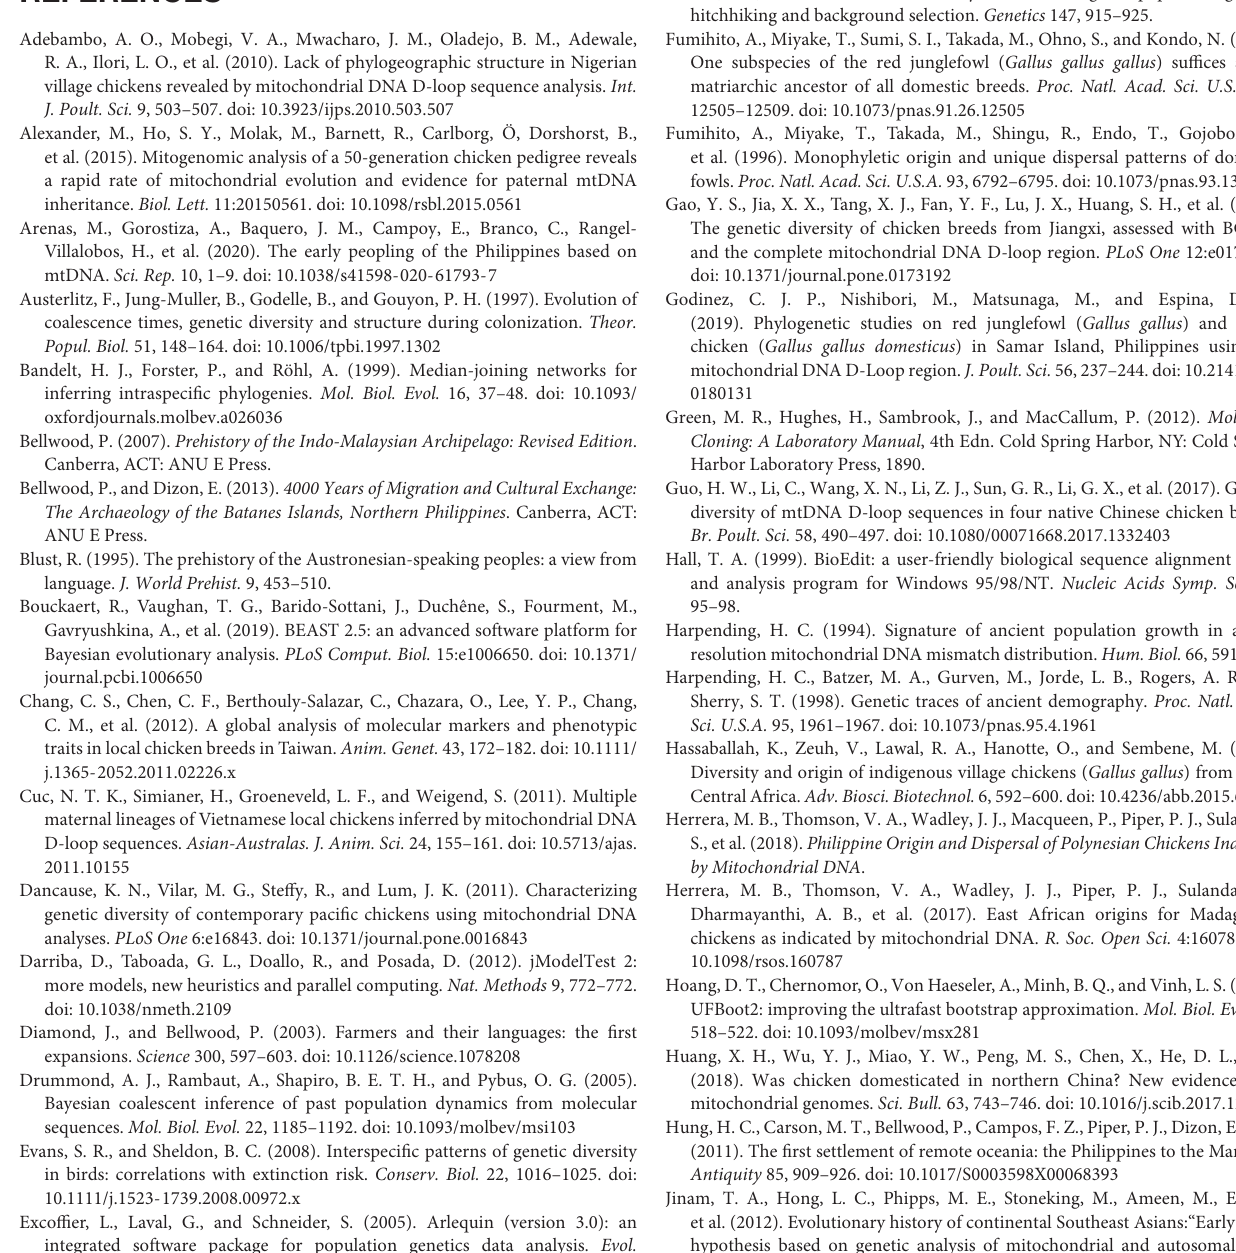
Genetic distance between Philippine–Pacific sub-clade and Philippine–Indonesian sub-clade are indicated by the length of branch corresponding for mutational positions. The area of each circle is proportional to the frequency of the corresponding haplotypes. Supplementary Figure 3 | Principal coordinate analysis (PCoA) plots of the population pairwise inter-haplotypic distance matrix for chicken populations in the islands of Southeast Asia (ISEA) and mainland Southeast Asia (MSEA) at complete D-loop region. Populations are assigned the following colors (Green: